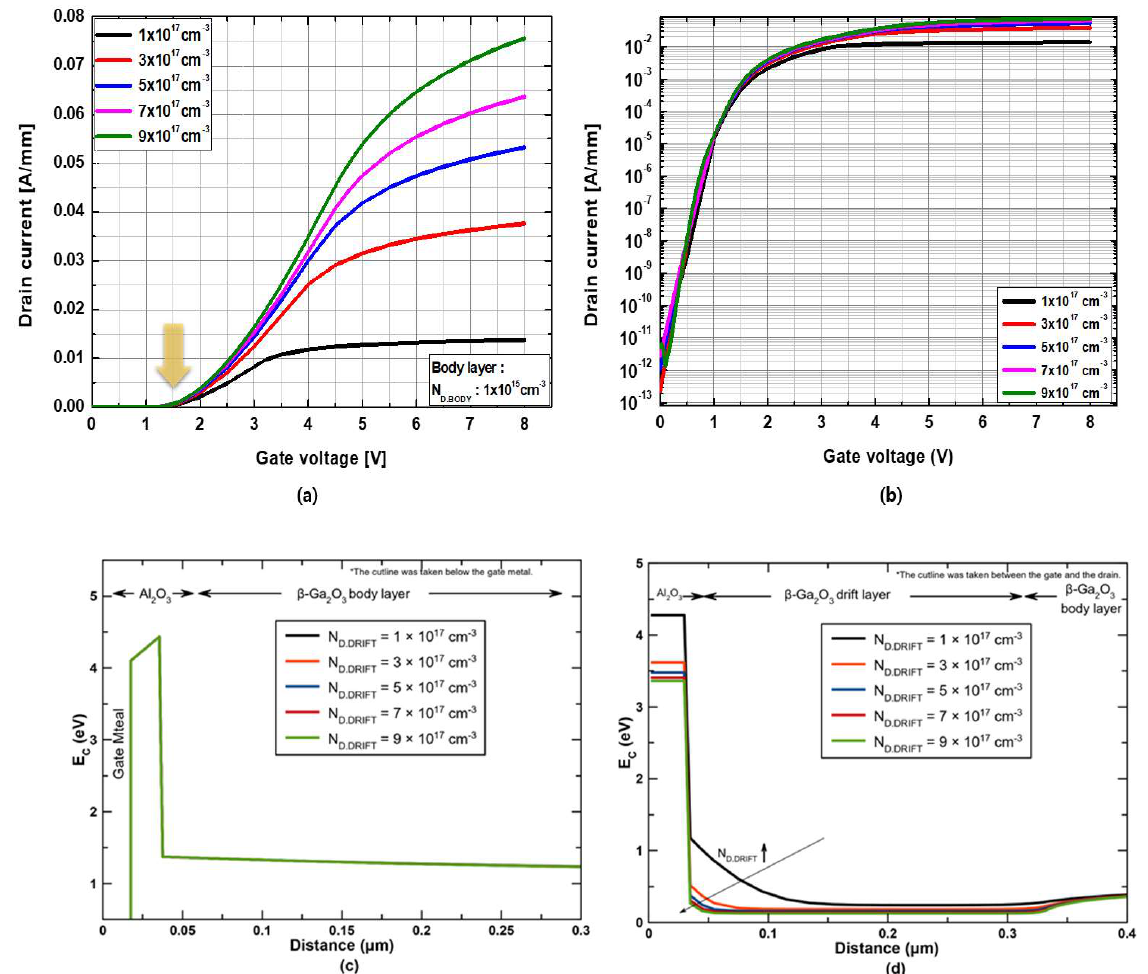
Figure 5. ( a ) Linear and ( b ) logarithmic transfer characteristics at V DS = +5 V as a function of the doping concentration of the drift channel layer. Conduction band energy diagrams as a function of N D.DRIFT along the vertical direction ( c ) under the gate metal and ( d ) in the region between the gate and drain at zero gate bias condition.